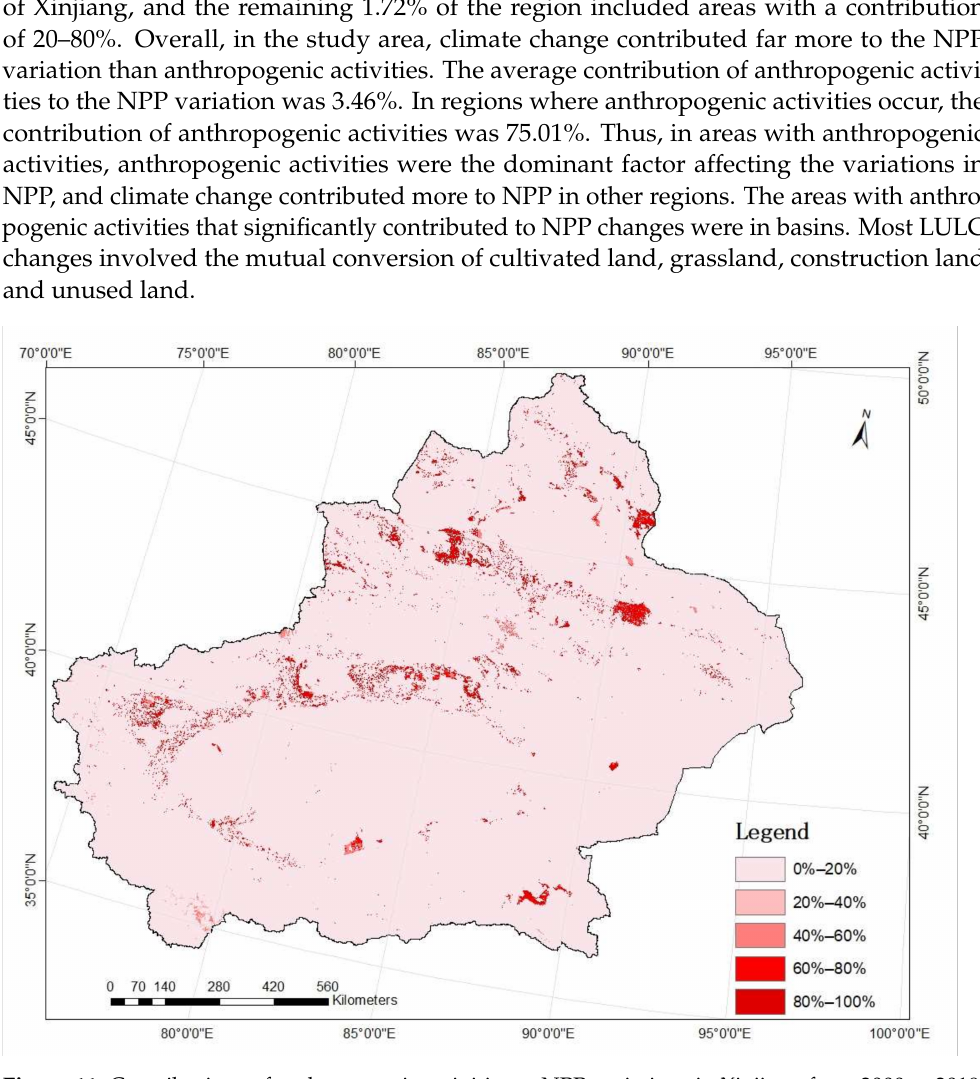
Figure 11. Contributions of anthropogenic activities to NPP variations in Xinjiang from 2000 to